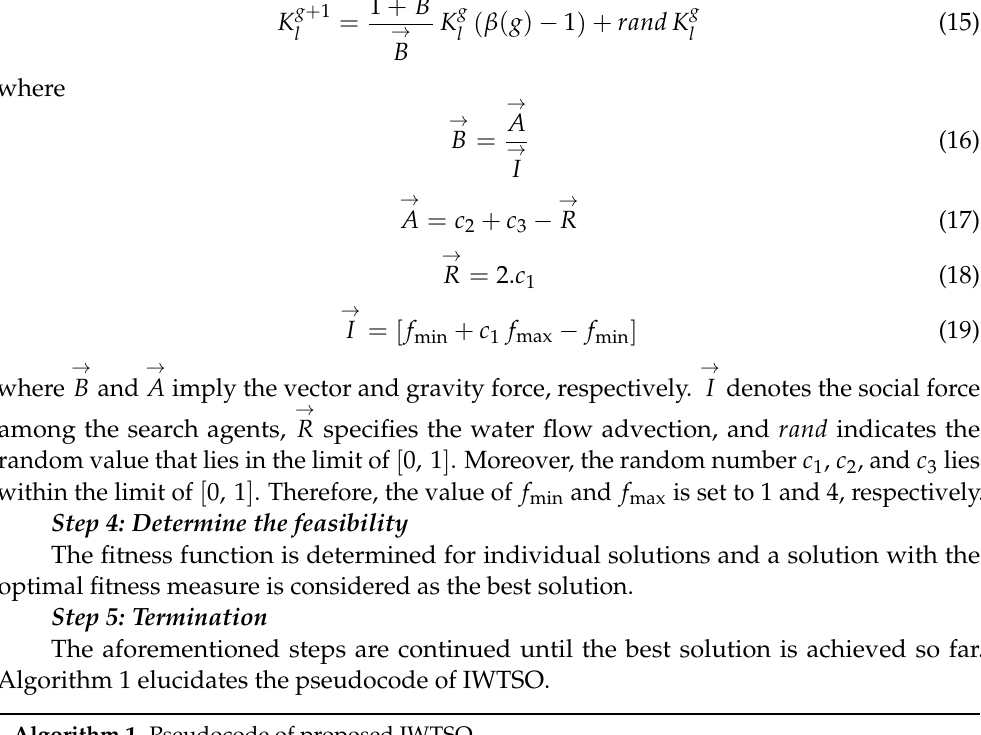
Algorithm 1. Pseudocode of proposed